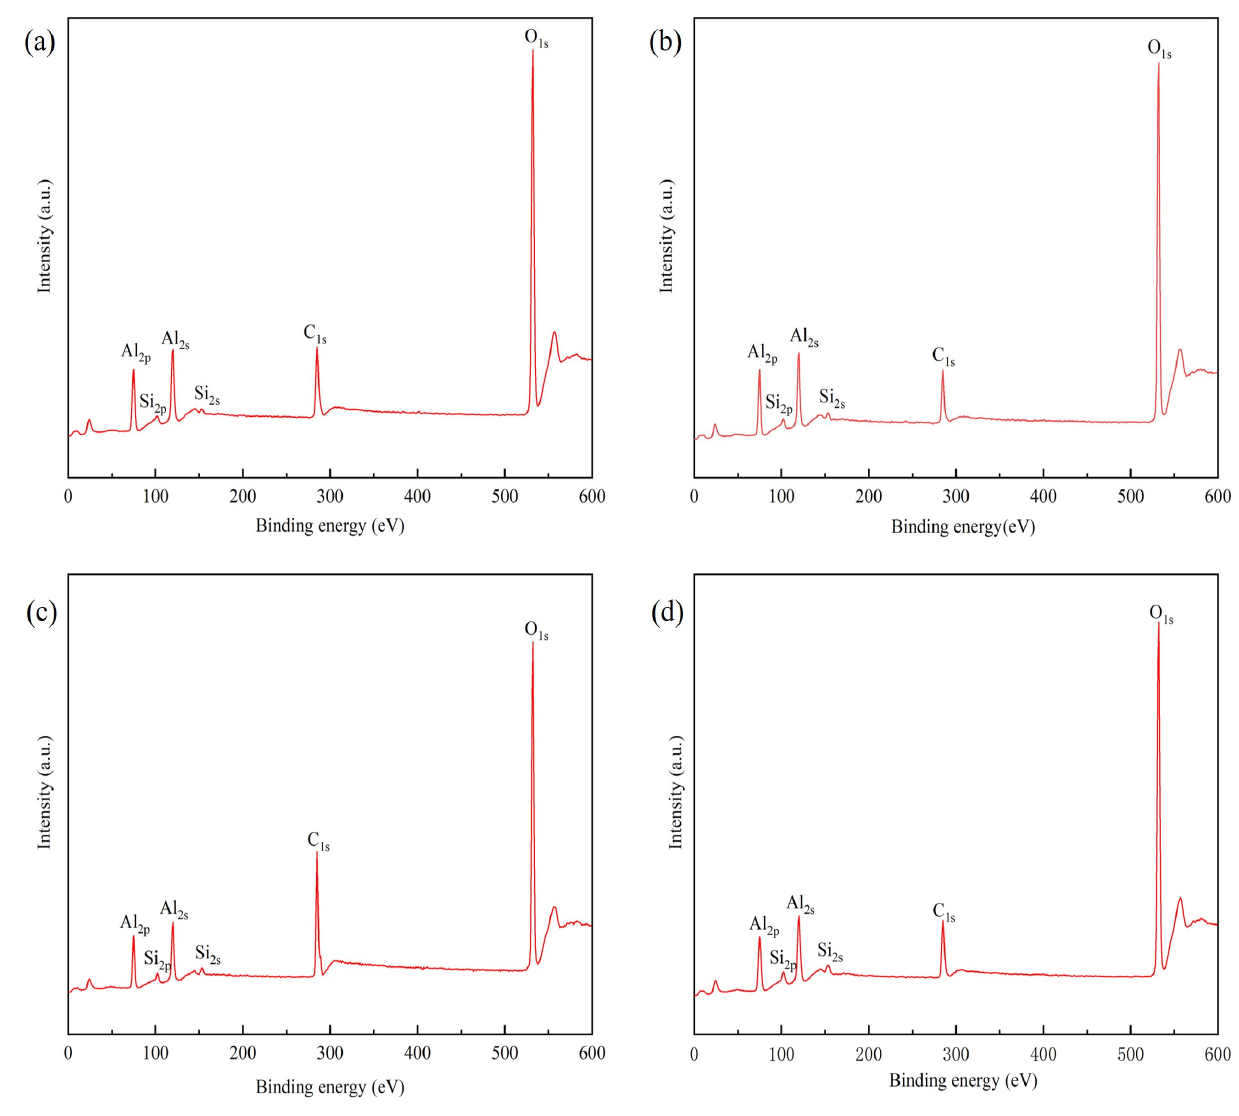
Figure 3. XPS full-survey spectra of Al 2 O 3 /C mixed powder with different contents of dispersants: ( a ) 2.5 wt%, ( b ) 5 wt%, ( c ) 7.5 wt%, ( d ) 10